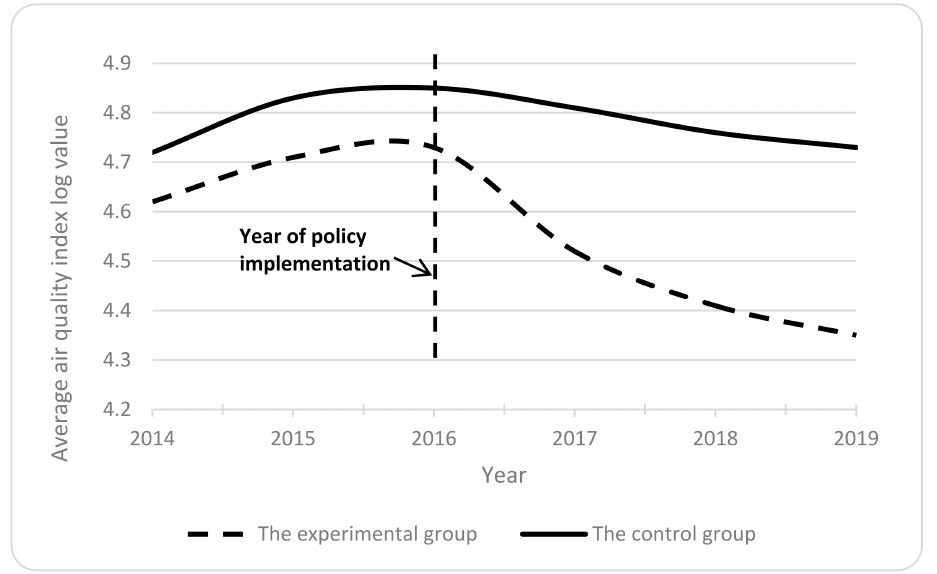
Figure 1. Air quality index change